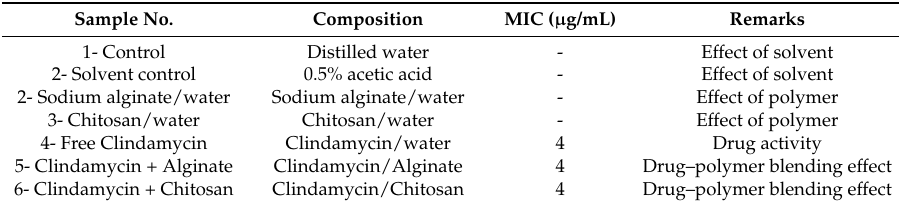
Table 3. Results of agar dilution susceptibility